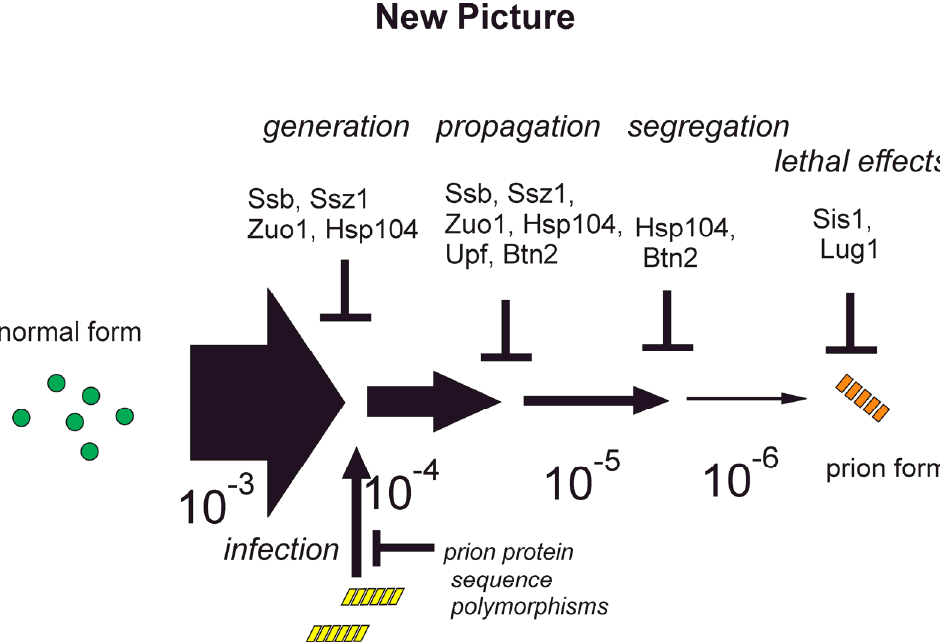
Figure 3. Anti-prion systems turn a tsunami of prions into a slow drip [65]. It was formerly thought that prion formation was extremely rare (1 in 10 6 cells or animals) and that once formed, their propagation (and death of the animal) was assured (“The Old Picture”). The discovery of anti-prion systems and their interactions reviewed here shows that prion formation is at least 1000-fold more frequent but that only a rare nascent prion emerges. Prions are blocked at various stages.